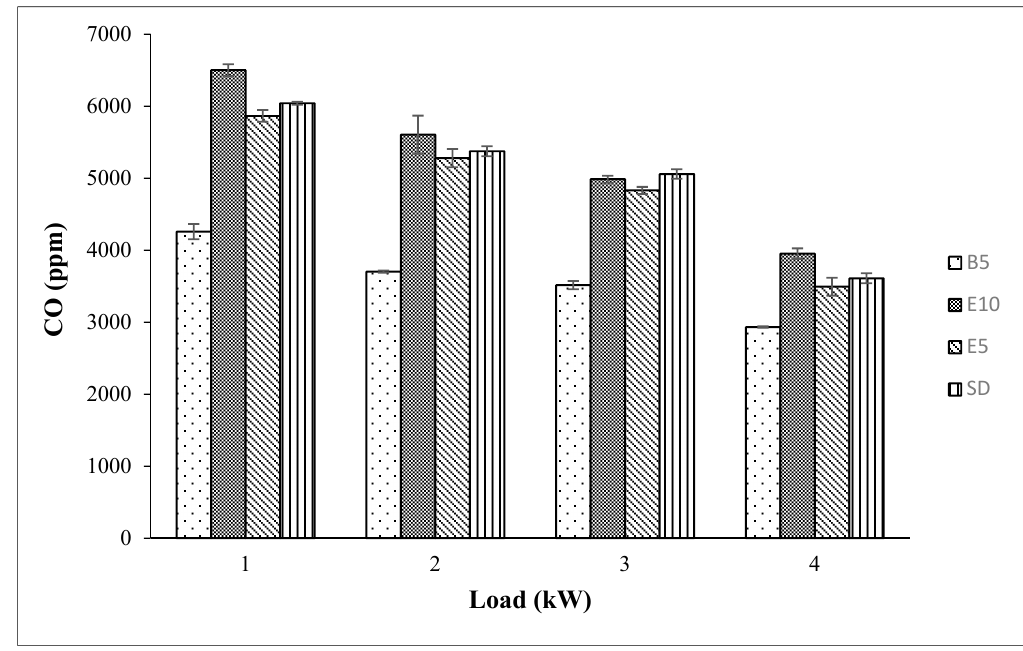
Figure 18. Concentration of CO for B5, E10, E5, and SD under different load conditions.